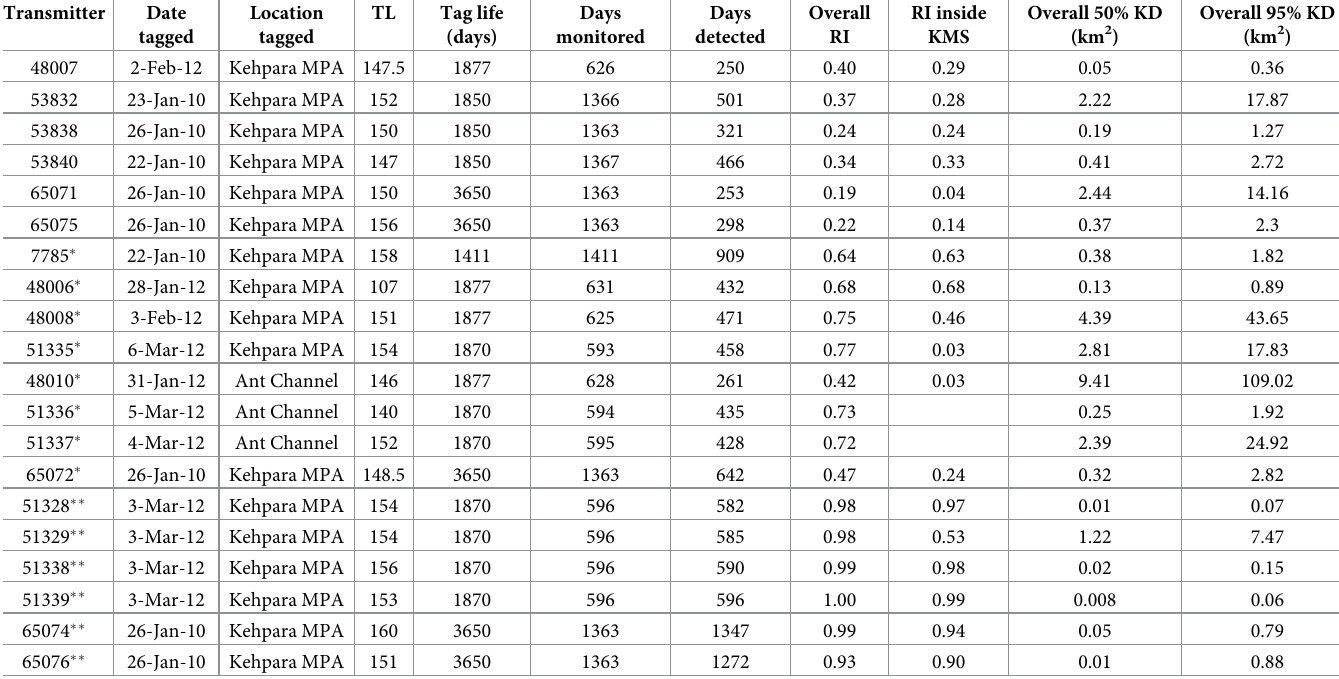
Table 1. Tagging information, residency indices (RI), and Kernel Density (KD) estimates 1